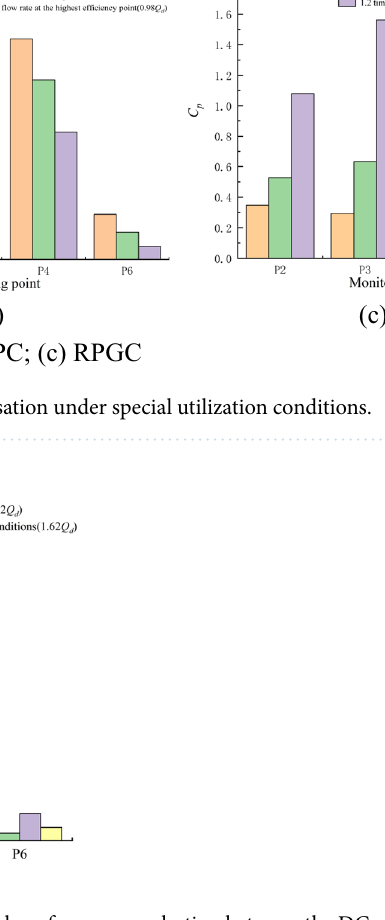
Figure 18. Comparison of the peak-to-peak value of pressure pulsation between the DC and special utilization